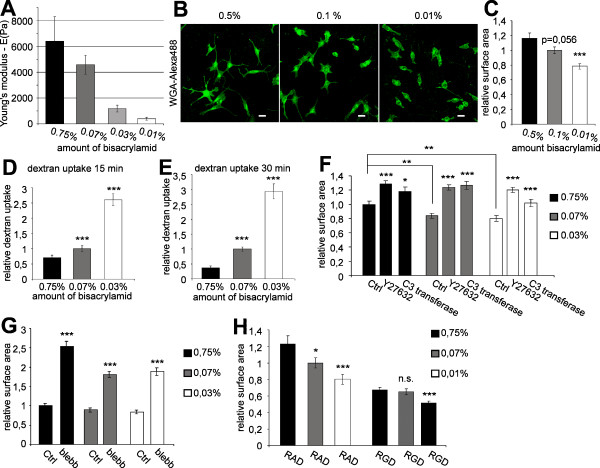
Matrix rigidity regulates cell surface area and endocytosis in Oli-neu cells. (A) Quantification of the elastic shear moduli of polyacrylamid gels on glass coverslips with varying amounts of bisacrylamid. Values represent means ± SD (n > 30 measurements). (B) Oli-neu cells were cultured for 1 d on polyacrylamid gels of different rigidities (using bisacrylamid varying from 0,5% to 0,01%) and analyzed for surface area differences by staining with Alexa Flour 488 conjugated wheat germ agglutinin (green). Scale bar, 10 μm. (C) Quantification of the surface area of Oli-neu cells on polyacrylamid gels of different rigidities (mean ± SEM; n > 100 cells, ***p < 0,001). (D+E) Cells were cultured for 1 d on polyacrylamid gels of different rigidities by varying the amount of bisacrylamid. Changes in the amount of dextran uptake ((D) 15 min and (E) 30 min) were quantified. Values represent the mean ± SEM (n > 60 cells from three independent experiments, ***p < 0,001). (F) Quantification of cell surface area of Oli-neu cells cultured on polyacrylamid gels for 1 d and treated for 10 h with 10 μM Y27632 or C3 transferase (mean ± SEM; n > 100 cells, *p < 0,05, **p < 0,01, ***p < 0,001). (G) Quantitative analysis of surface area changes of Oli-neu cells cultured for 1 d on polyacrylamid gels and treated with 50 μM blebbistatin (blebb) for 10 h (mean ± SEM; n > 60 cells, ***p < 0,001). (H) Oli-neu cells were cultured on polyacrylamid gels of different rigidities, treated with RGD-peptide or inactive RAD-peptide and changes in relative surface area were quantified. Values represent the mean ± SEM (n > 80 cells, *p < 0,05, **p < 0,01, ***p < 0,001).